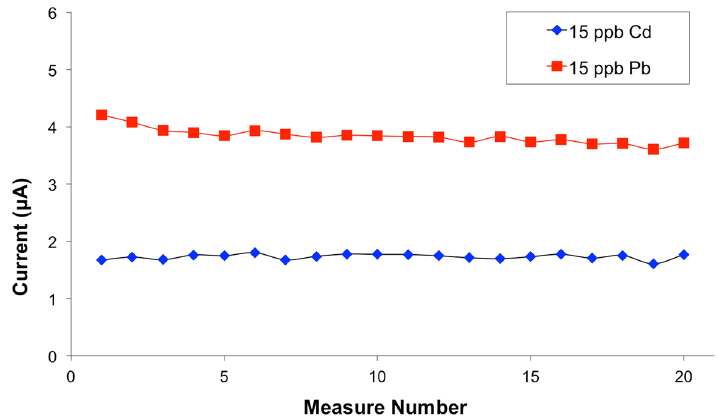
Figure 6. Long-term stability of cadmium and lead signals in differential-pulse stripping on a Bi/PO 4 /PSS(B) electrode.